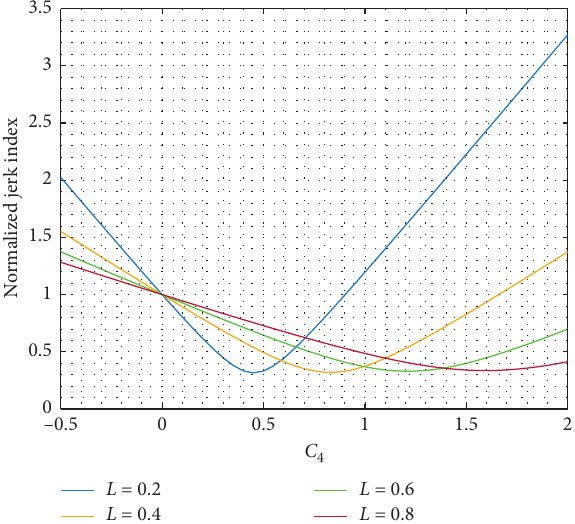
Figure 8: Normalized jerk index versus the fourth input constant ( C 4 ) for different cable lengths with the standard maneuver